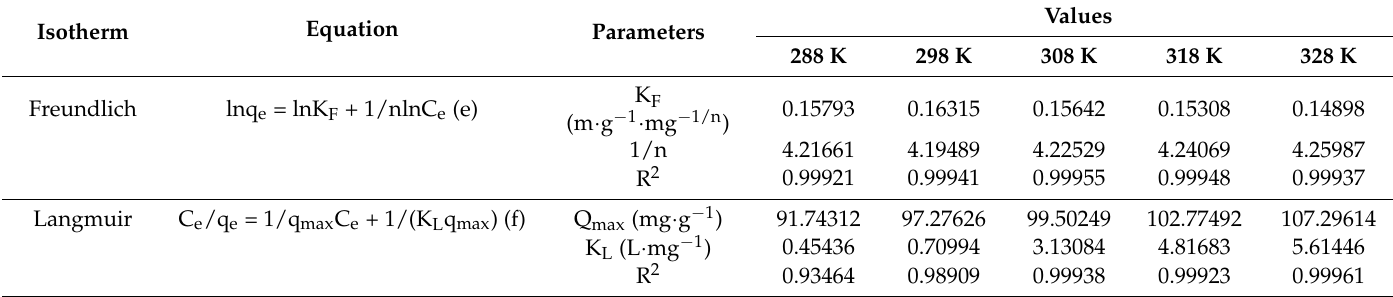
Table 2. Freundlich and Langmuir isotherm parameters for adsorption of